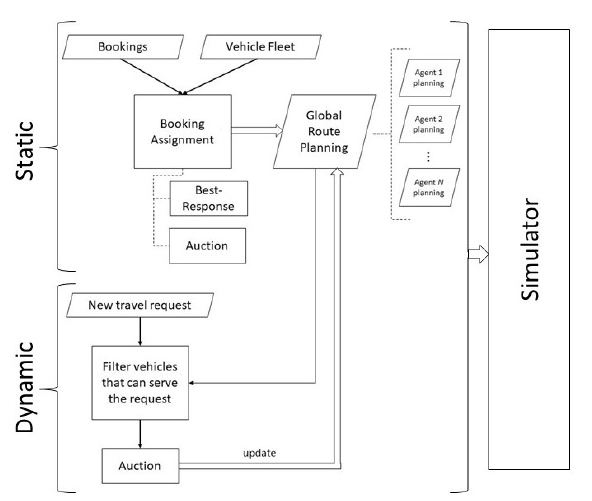
Figure 1. System architecture, split into a static and a dynamic subsystem. The proposed architecture may be communicated to a simulator which allows for system testing, tuning and